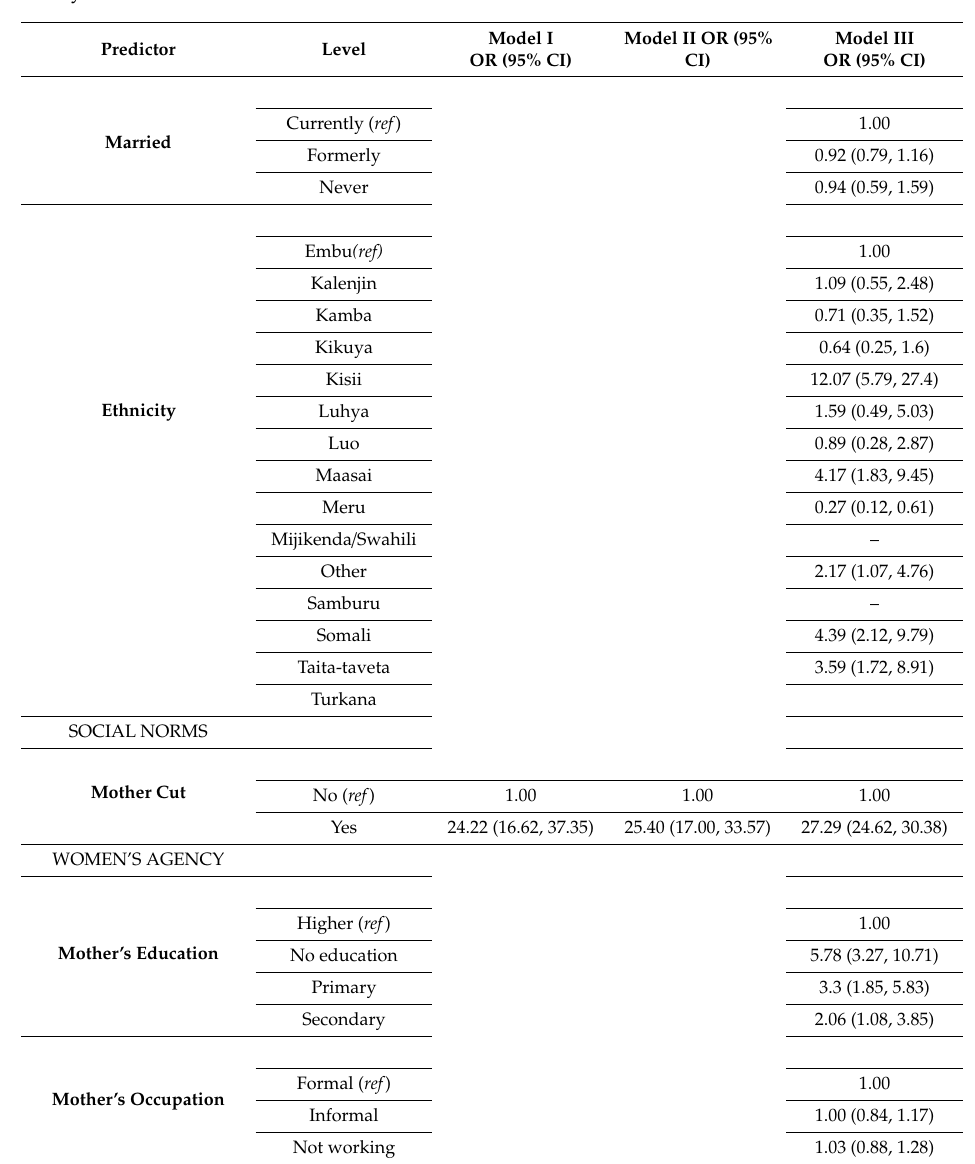
Table A3. Unadjusted and adjusted posterior odds ratios (POR) and associated 95% credible region (CR) of circumcision of Girls ages 0–14 across selected covariates (Kenya, DHS 2003–2014 combined) from Bayesian Geo-additive